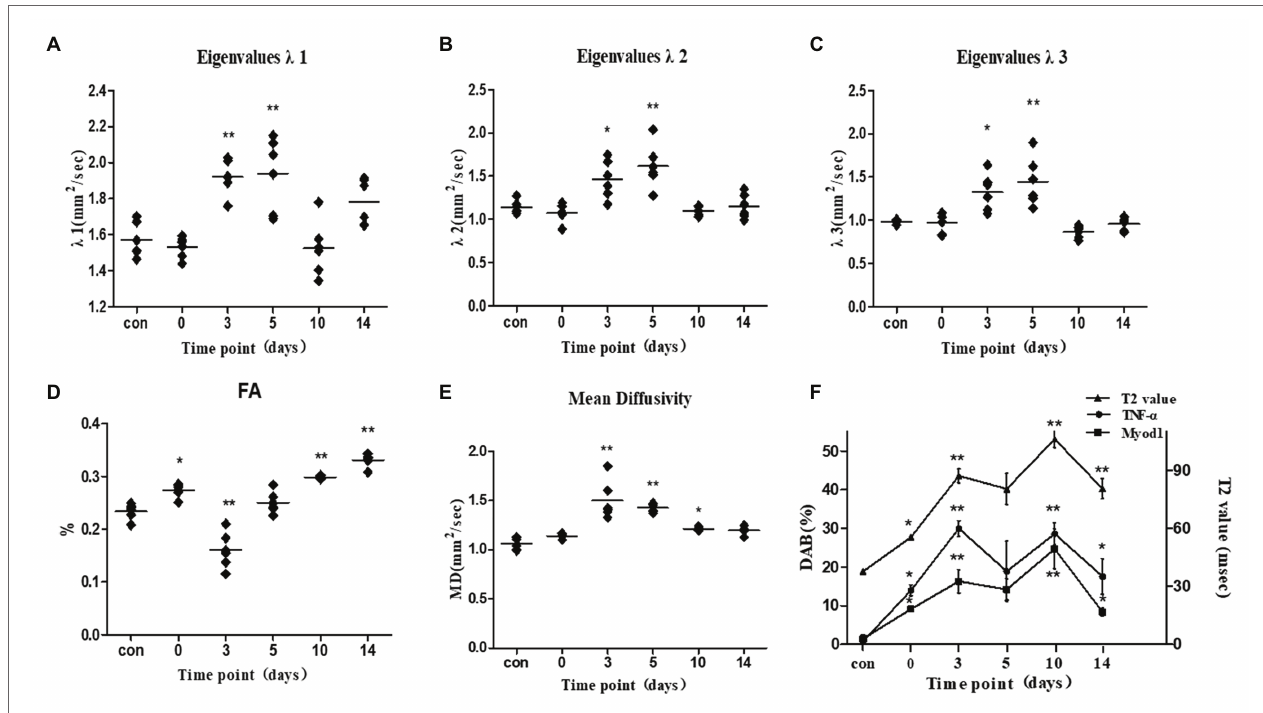
FIGURE 5 | (A–F) Frostbite skeletal muscle eigenvalues λ 1, λ 2, λ 3, FA, MD, and T2 at different time points. Compared with the control group, the frostbite muscle MD and λ 1, λ 2, and λ 3 increased from 3 to 5 days, and FA decreased. The last picture is a schematic diagram of the T2 value, TNF- α , and Myod1. The three curves represent relative expression levels of T2 values, TNF- α , and Myod1. The T2 values show a bimodal change. * p < 0.05, ** p < 0.01.